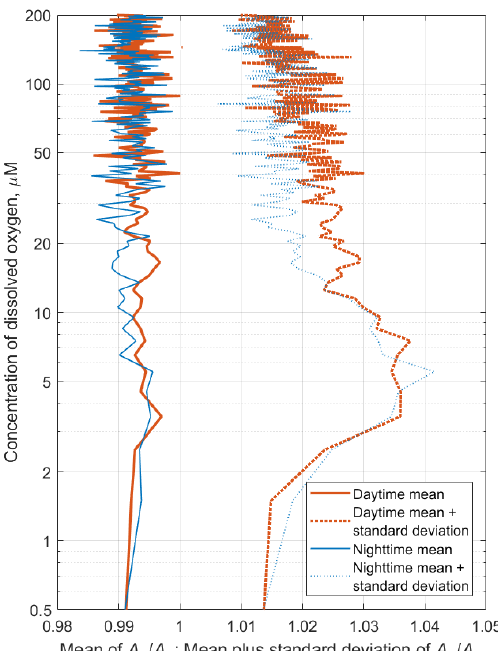
Figure A1. Monthly averages of the depth profiles of the acoustic backscattering amplitude ratio A 1 /A 2 for the time series of the daytime (solid red line) and nighttime (blue solid line) data in July 2019. Dotted lines indicate the values of the standard deviations from the means.